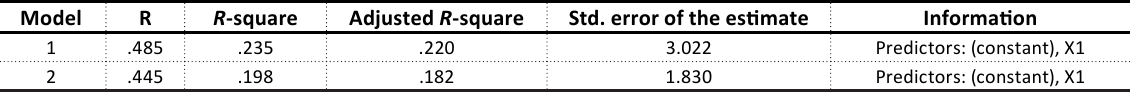
Table 2. Coefficient determination test results